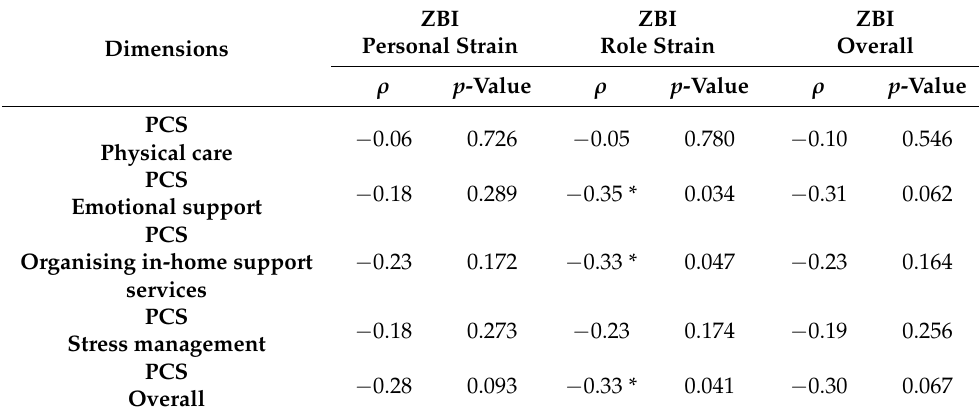
Table 4. Associations between the dimensions of Preparedness for Caregiving and the dimensions of Burden according to Spearman’s correlation coefficient ( ρ